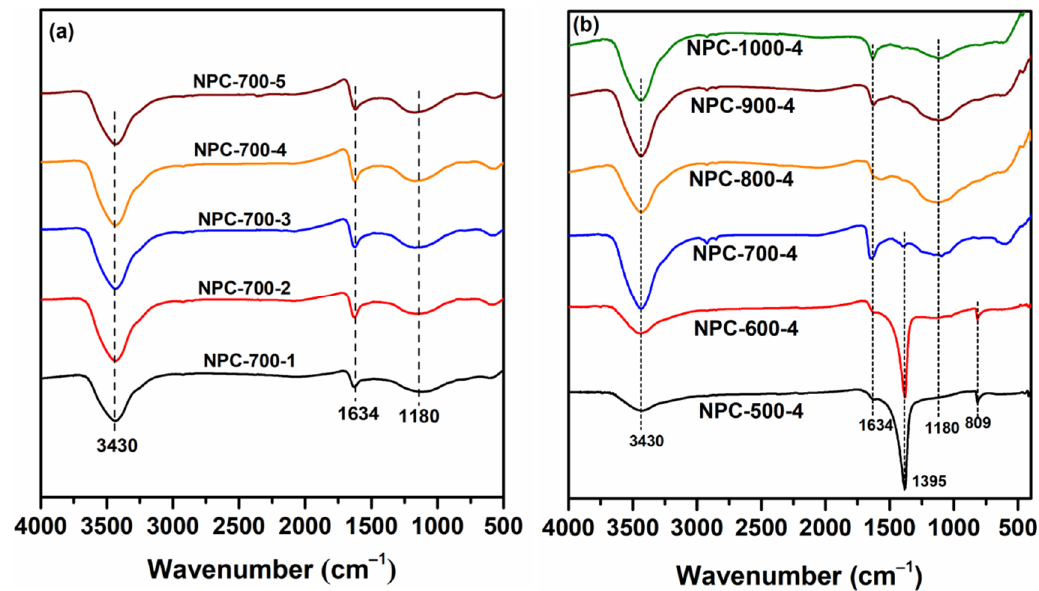
Figure 1. FT-IR spectra of NPC-700-x ( a ) and NPC-y-4 ( b ).